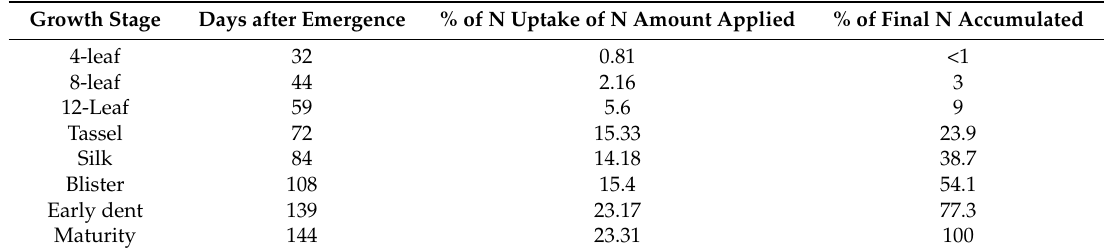
Table 1. Accumulation of N in maize throughout the season